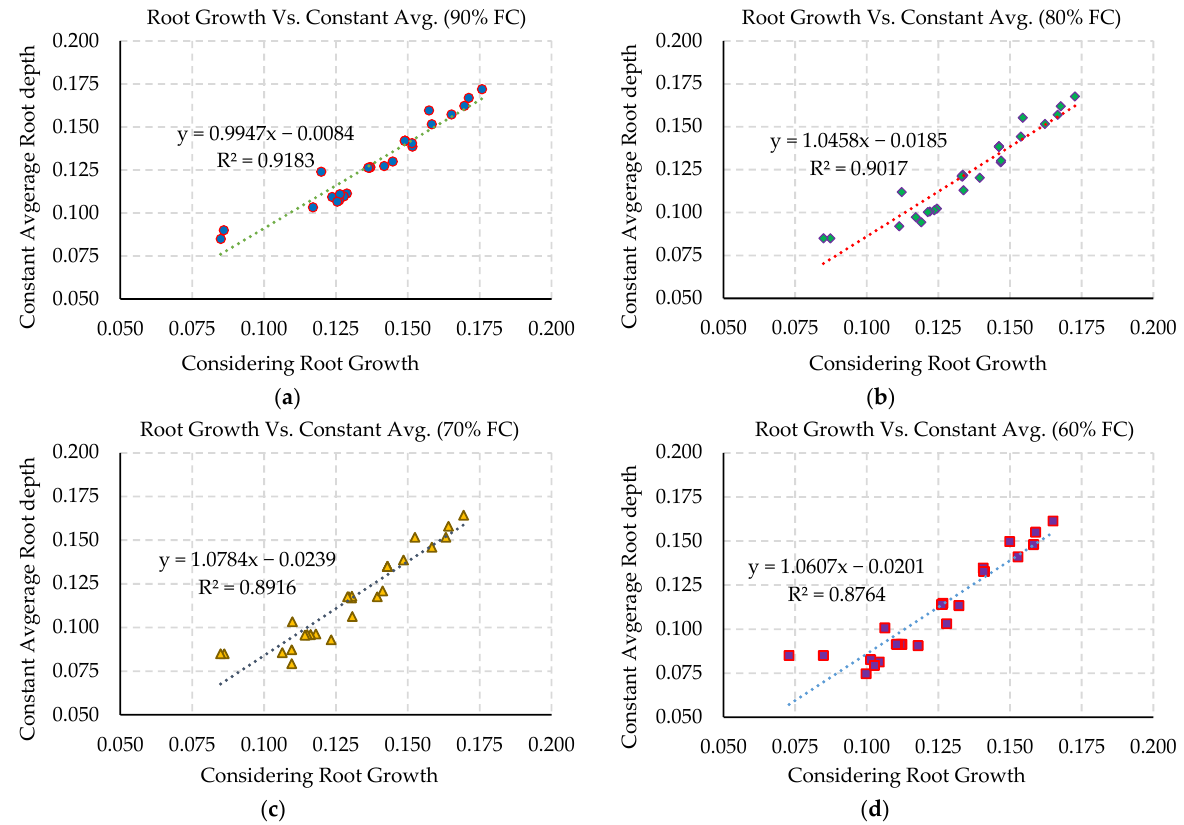
Figure 6. Relationship for SWC between the constant average root depth and root growth module for ( a ) T 90 , ( b ) T 80 , ( c ) T 70 , and ( d ) T 60 .